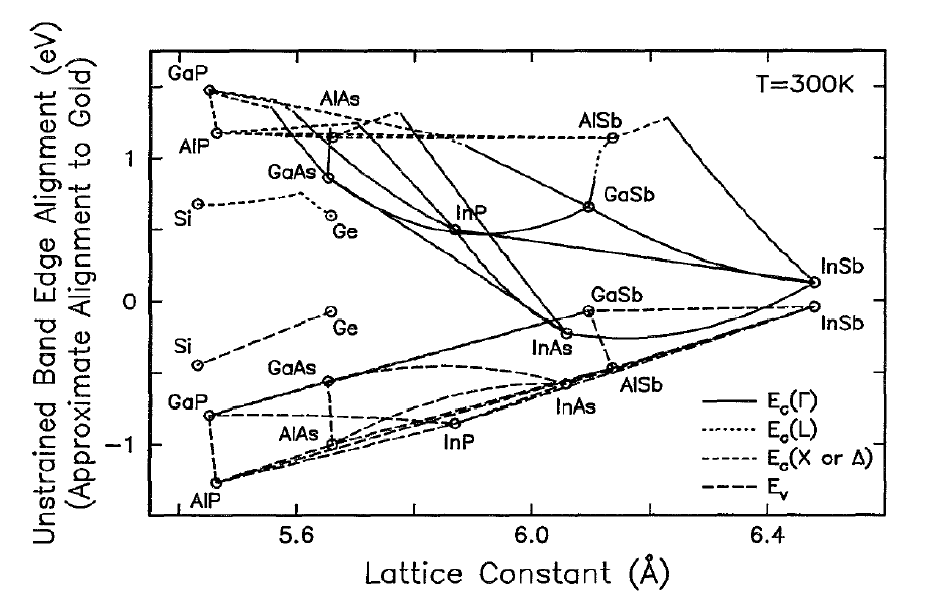
Figure 7. Conduction band edge and valence band edge energies plotted as a function of the lattice constant of semiconductors. The zero energy point represents the approximate gold Schottky barrier position in the band gap of any given alloy (reused with permission from [20]; © 1992, American Institute of